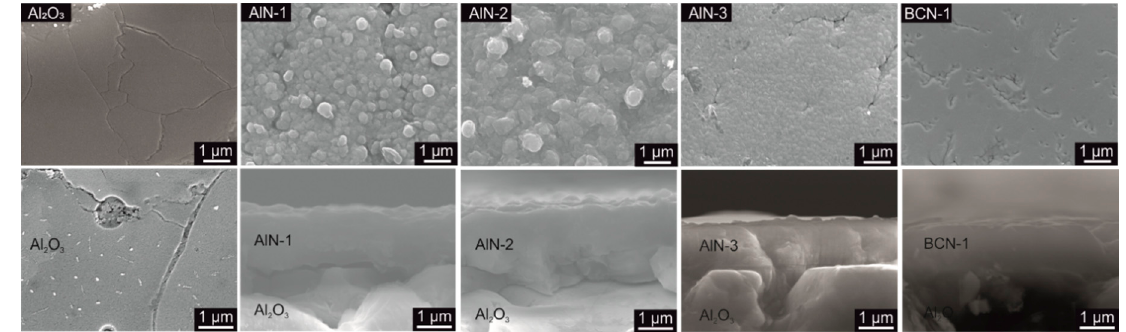
Figure 2. SEM images of the topography (top) and morphology (bottom) of the AlN-1, AlN-2, AlN-3, and BCN thin films, as well as the thermally sprayed Al 2 O 3 coating.